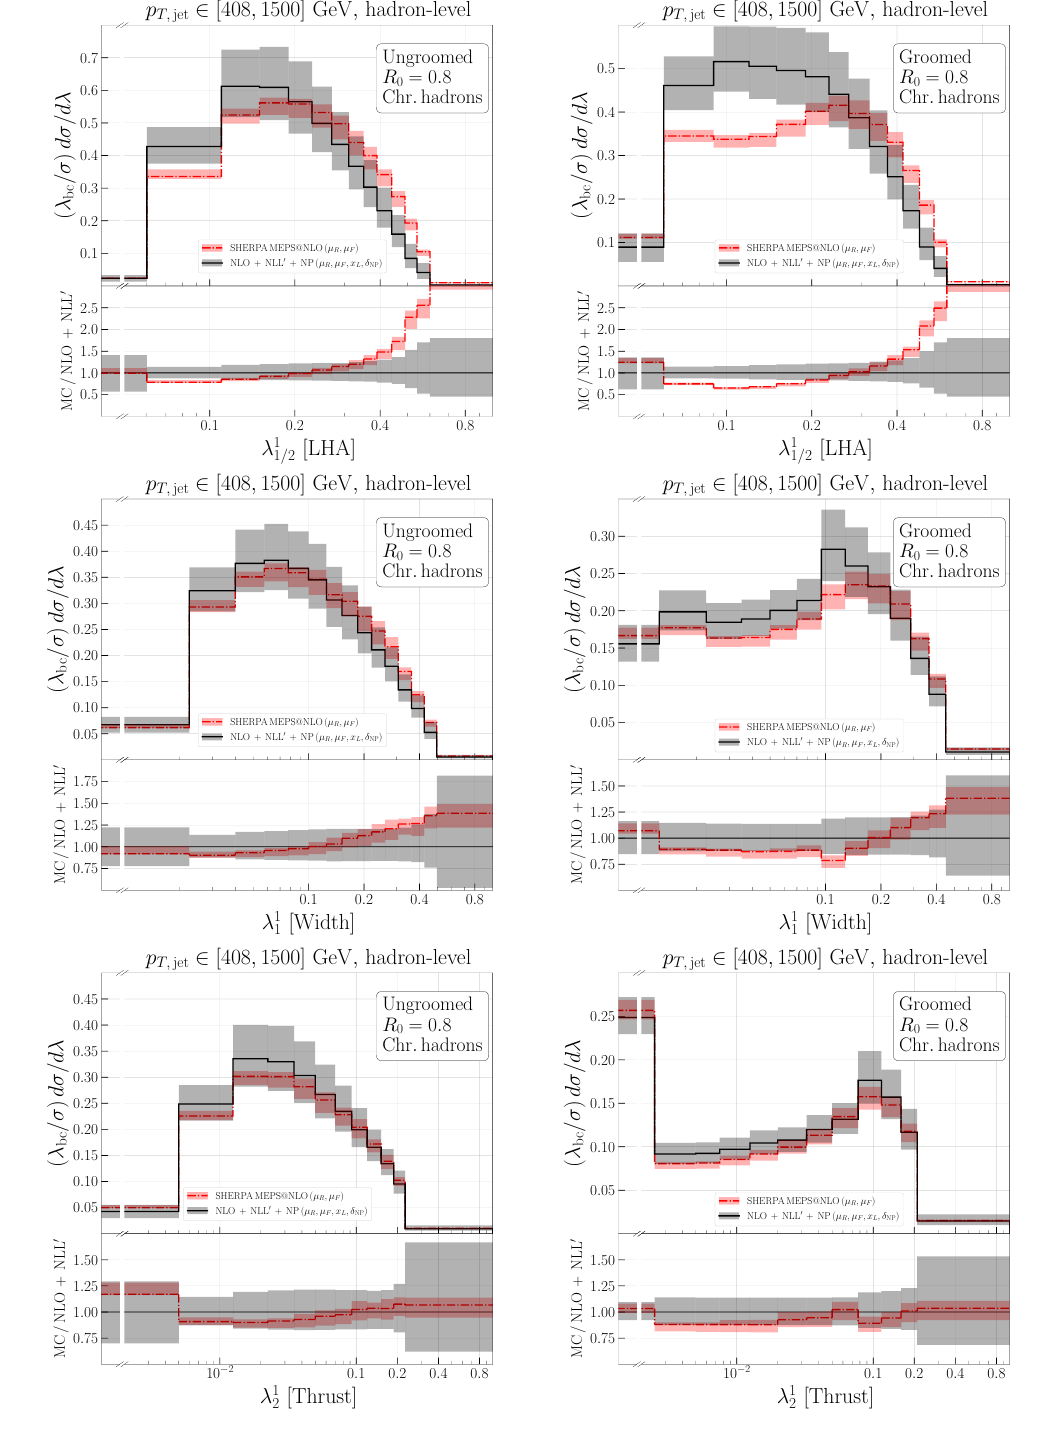
Figure 17 . Comparison of hadron-level predictions from S HERPA (MEPS@NLO), based on charged hadrons only, for ungroomed and groomed jet-angularities in Zj production, with p T, jet ∈ [408 , 1500] GeV, with NLO + NLL 0 results corrected for non-perturbative effects. Here λ bc stands for the bin